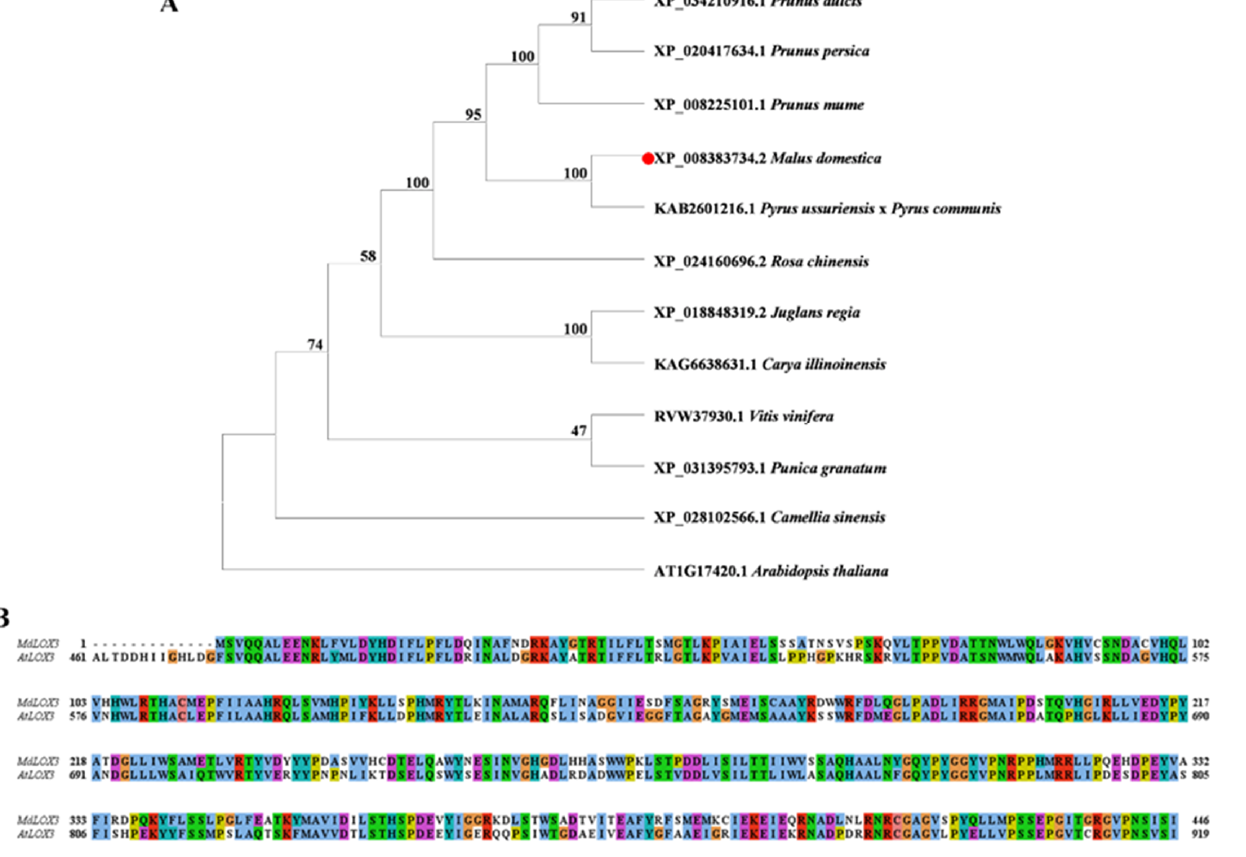
Figure 2. Phylogenetic tree analysis and amino acid sequence alignment of the MdLOX3 protein. ( A ) The phylogenetic relationship between MdLOX3 and LOX3 proteins from other plant species via MEGA 11. ( B ) Alignment of between MdLOX3 and AtLOX3 amino acid sequences. Red circles indicate MdLOX3 ( Malus × domestica )